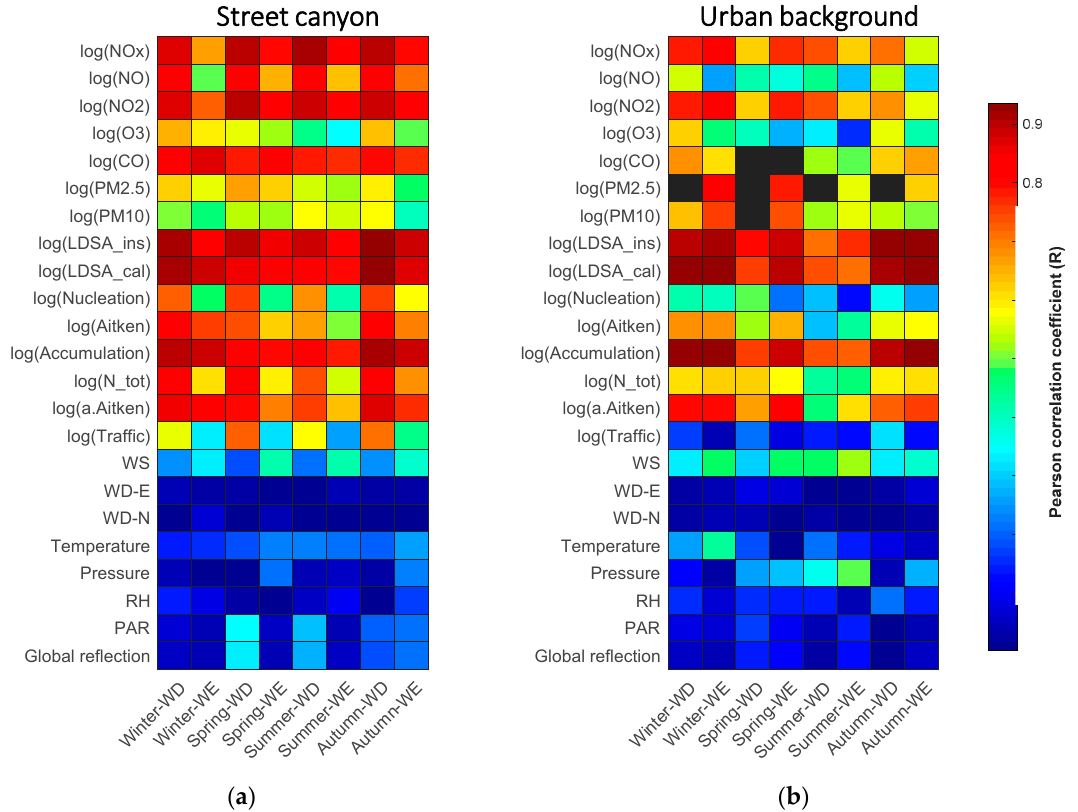
Figure 5. Matrixplots showing the Pearson correlation coefficients of the logarithm of BC with other variables in eight classes as shown in the columns. ( a ) and ( b ) illustrate the data in the street canyon in Mäkelänkatu and the urban background in Kumpula, respectively. The redness of grid represent the degree of correlation. Blue colors show the least correlated variable combination. Black color represents the data in that period is missing.